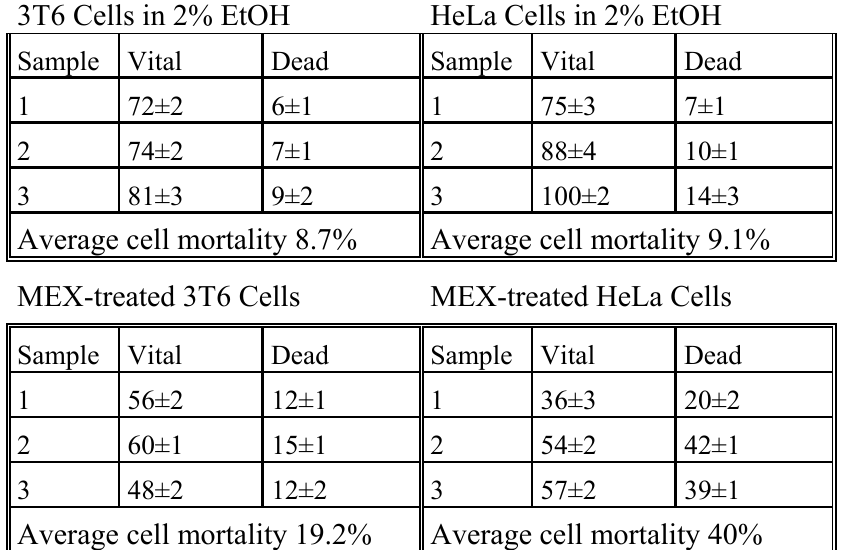
Table 1. Schematic summary of cell death induced by ethanol and Mex on 3T6 and HeLa cells. Treatment with MEX was continued for 24 hrs at a concentration of 0.5 mg/mL. Three independent experiments were performed and results are shown as ± standard deviation (mean ±